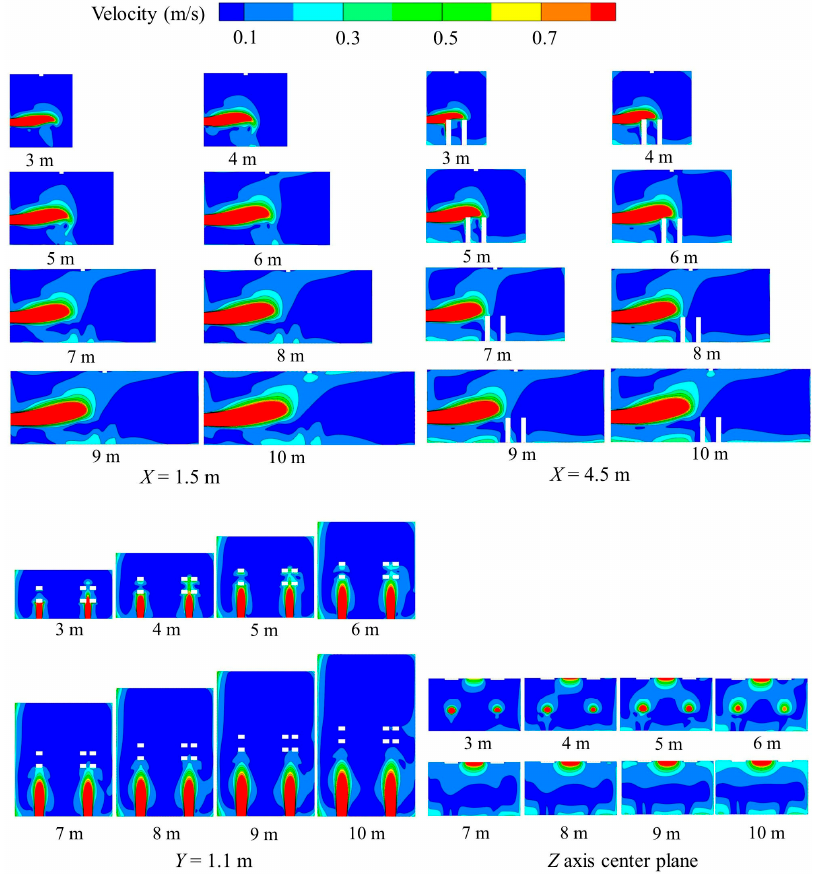
Figure 7. Velocity distribution in different room sizes.